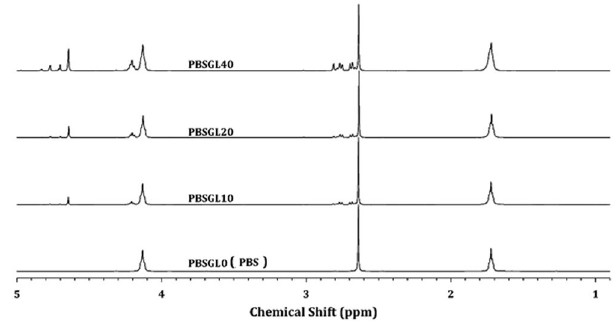
Figure 1. 1 HNMR spectra of PBSGL n samples.